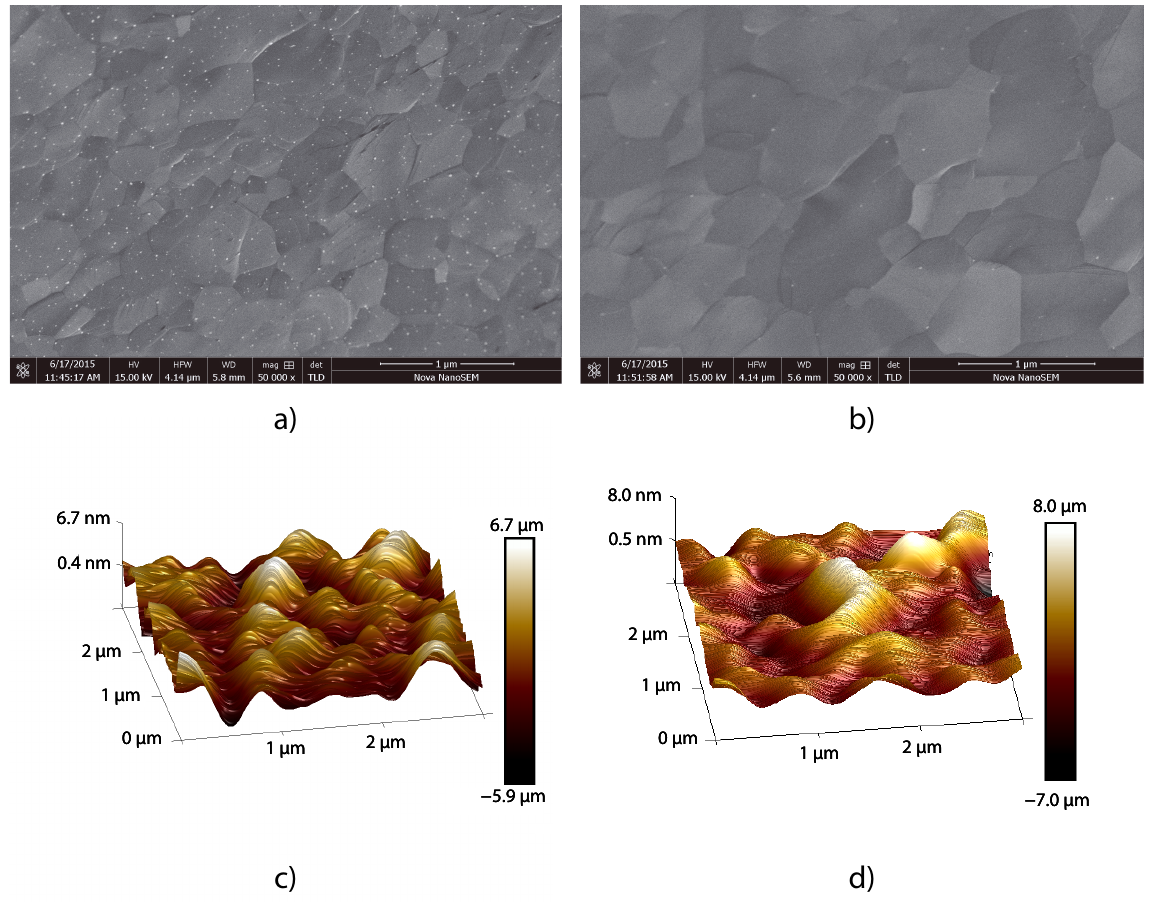
Figure 2. Scanning electron microscopy (SEM) and atomic force microscopy (AFM) of the platinum seed layer after annealing. ( a ) SEM of an area with a grain size of ∼ 0.5 µm after anneal in nitrogen gas. ( b ) SEM of an area with a grain size of ∼ 1.0 µm after anneal under atmospheric